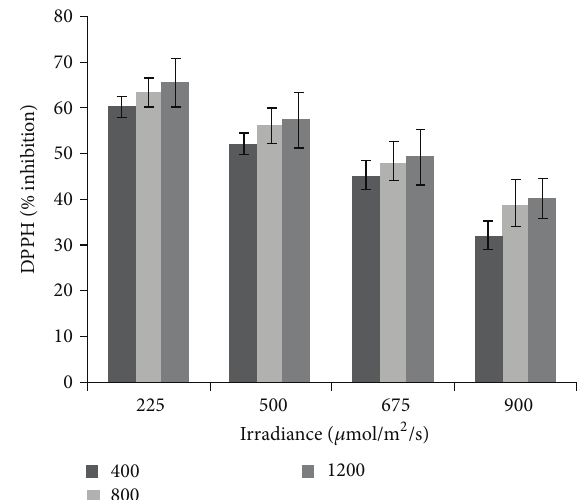
Figure 4: Interaction effect of CO 2 and irradiance on DPPH scavenging activity of Labisia pumila . BHT and 𝛼 -tocopherol were used as controls and valued at 66.41 and 80.41, respectively. 𝑁 = 21 . Bars represent standard errors of differences between means (SEM).